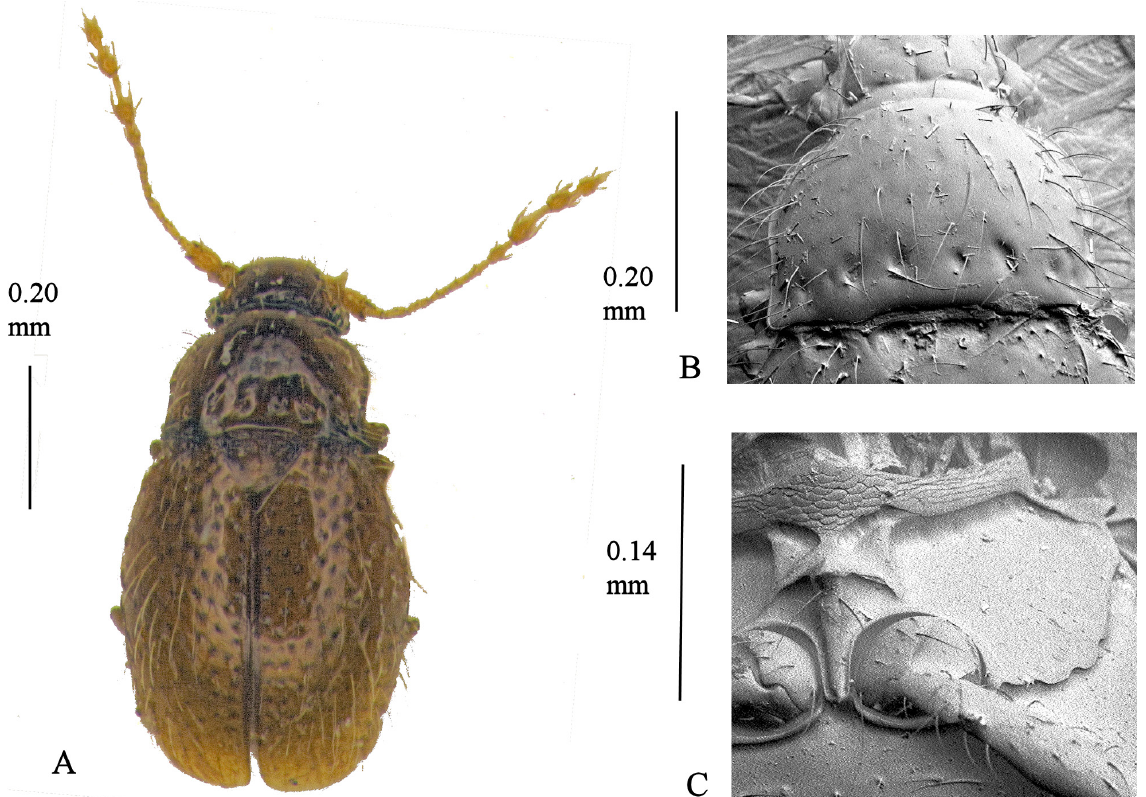
Fig. 20 . Cissidium crowsoni Johnson, 1982. A . Habitus. B . Pronotum, × 550. C . Mesoventrite showing median process of collar, mid-keel and keel,